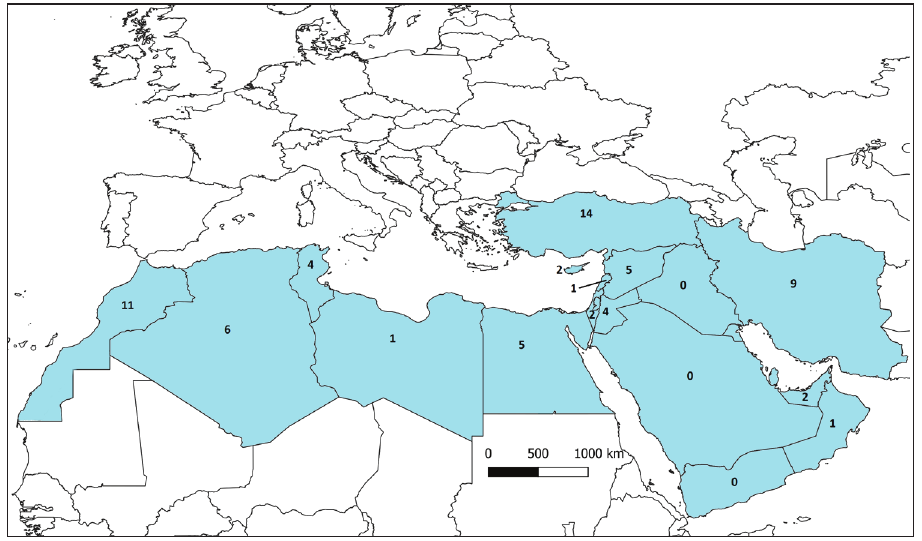
Figure 4. Map of the study region with numbers of species of Epeolus known from each